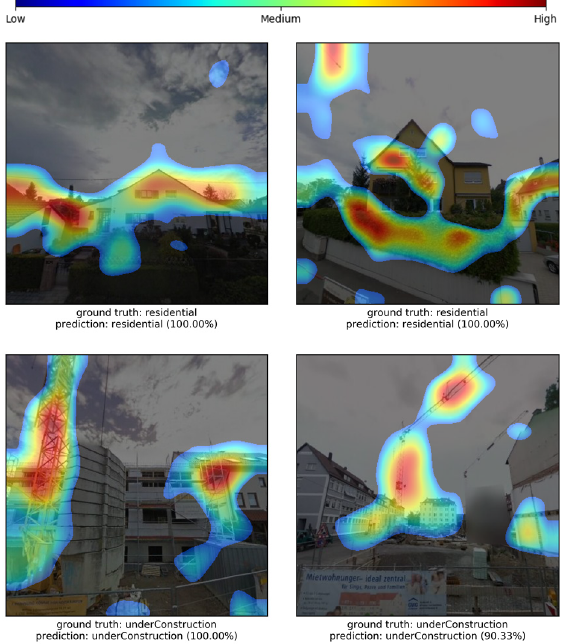
Figure 4. Correctly classified images with corresponding upsampled CAMs overlaid (binary classification). The respective color of the CAM represents the importance regarding the network’s